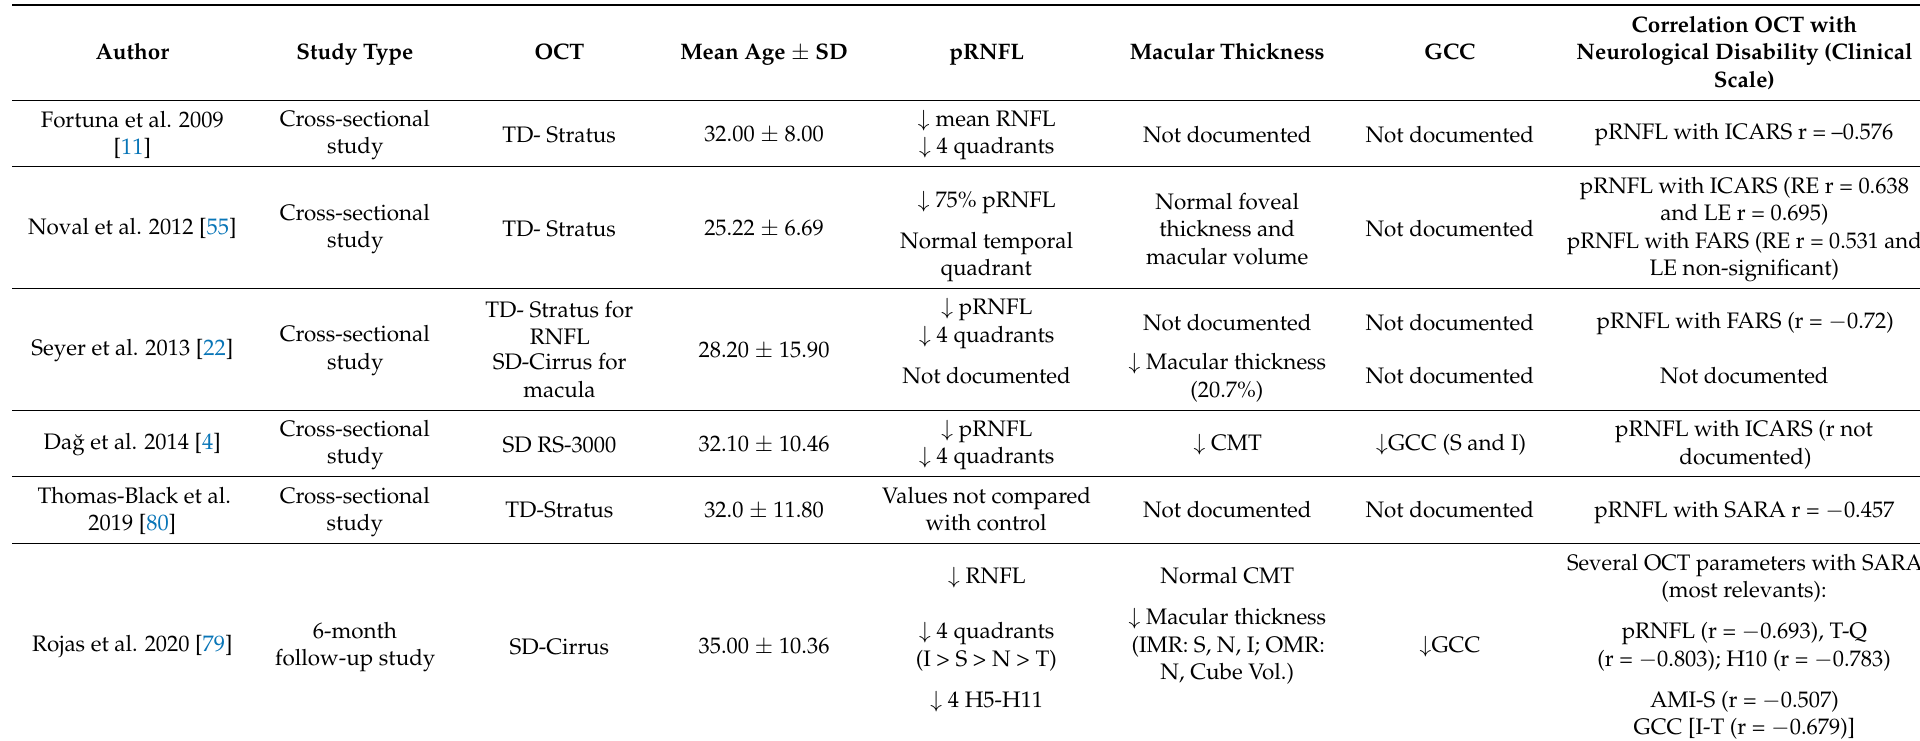
Table 3. Studies with OCT in FRDA